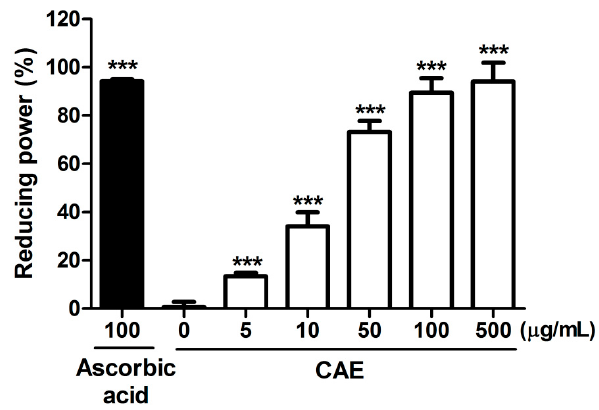
Figure 1. Reducing capability of CAE. Ascorbic acid (100 μ g/mL) was used as the positive control. The reducing capability of CAE at concentrations above 100 μ g/mL was similar to that of ascorbic acid. Significant difference versus control in each experiment: ***, p < 0.001.